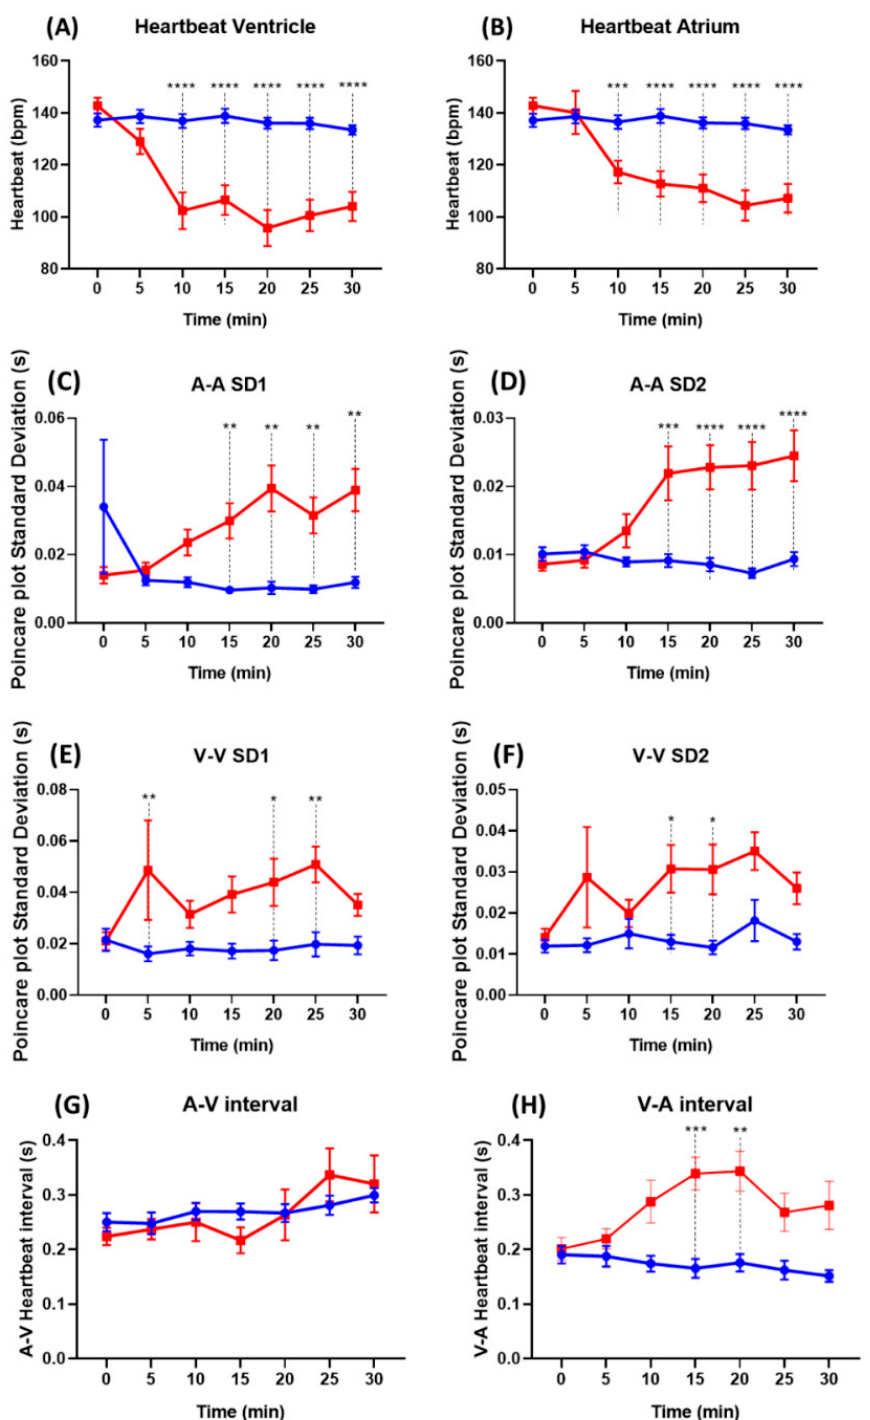
Figure 6. Effect of astemizole treatment on zebrafish cardiac parameters. ( A ) ventricle and ( B ) atrium heart rate, ( C – F ) atrium-atrium (A-A), and ventricle-ventricle (V-V) SD1 and SD2 calculated using a Poincare plot to present heart rate variability. ( G , H ) Atrium-ventricle (A-V) and ventricle-atrium (V-A) interval of zebrafish heartbeat. Blue line = control, red line = astemizole treatment. Zebrafish embryos were exposed to astemizole at 72 h post-fertilization, and the corresponding heart rate changes were monitoring over time for 30 min. Data were calculated using two-way ANOVA and presented as mean ± SEM. (* p < 0.5, ** p < 0.1, *** p < 0.001, **** p < 0.0001, n = 20).